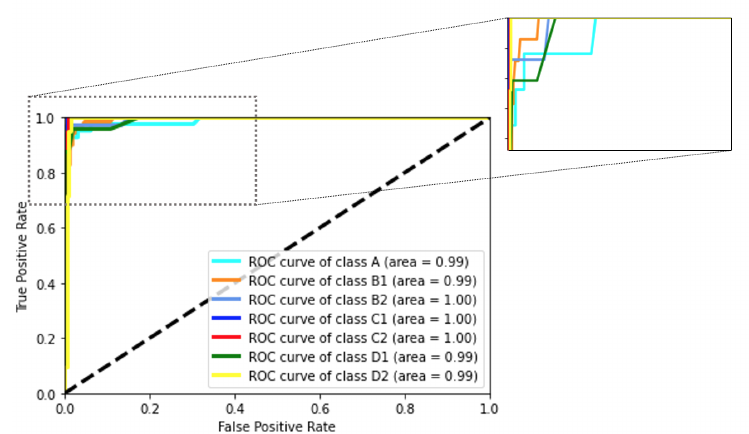
Figure 5. The ROC curve for the RF classifier is shown. The area under the curve for all of the labels is close to 1.0. The upper left part of the plot is zoomed in the inset, to show the variability of thresholds for each class. The classes are consistent with the definition of labels presented in Section 3.1.